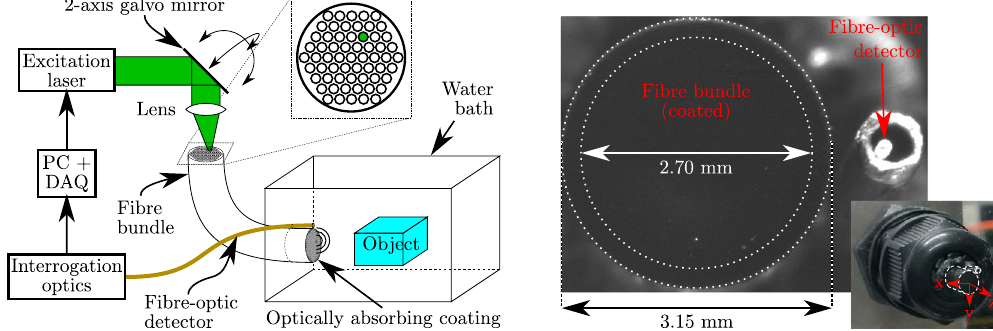
Figure 1. Left: Schematic of the experimental set-up. A two-axis galvo-mirror and lens are used to focus and arbitrarily steer laser light onto a small area of the proximal end of a coherent fibre bundle. The fibre bundle transports the focussed light to the corresponding area of an optically absorbing coating deposited at its distal end, where ultrasound is generated photoacoustically. Acoustic pulse-echo signals are recorded using a fibre- optic receiver. Right: Micro- and macroscopic photographs of the coated, distal end of the fibre bundle. The coordinate system used throughout this study is indicated. The ultrasound-generating area is limited by the inner dotted circle; the outer circle delineates the outer edge of the fibre